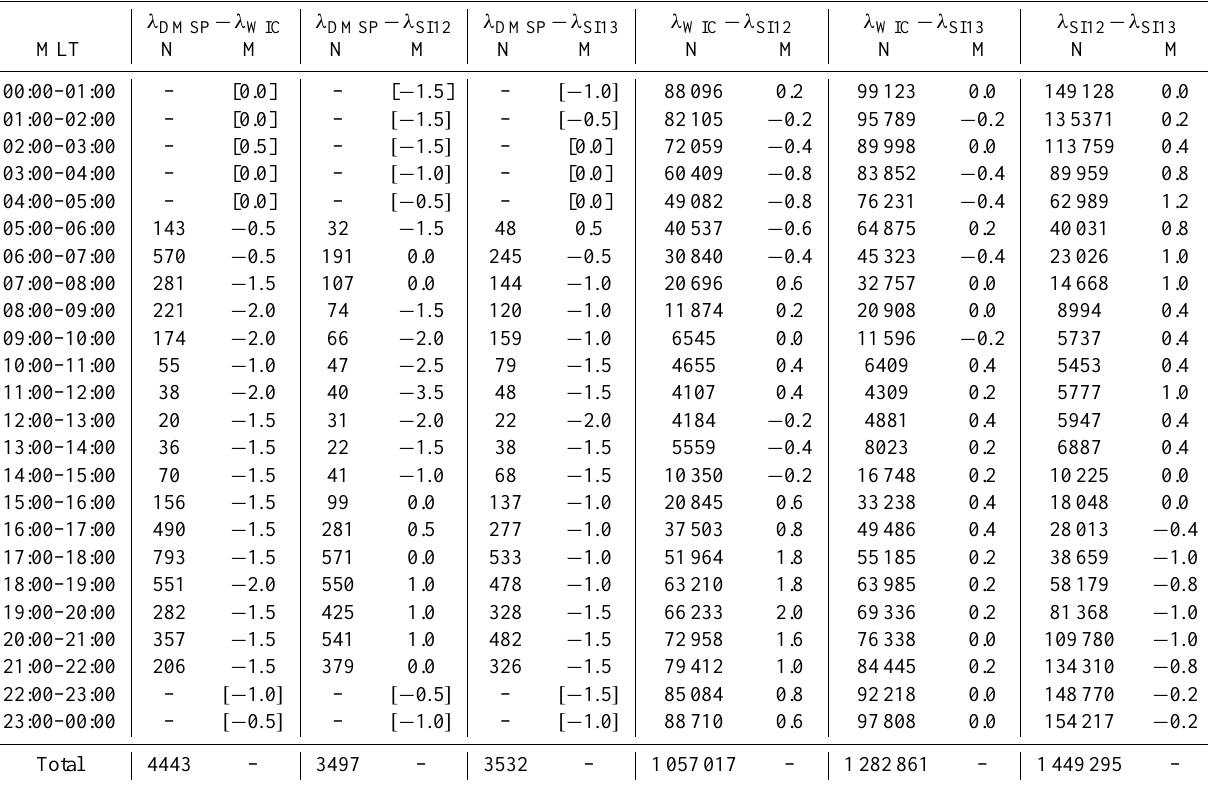
Table 3. The number (N) and mode (M) of comparisons of differences between DMSP PAPBs and FUV PALBs during 2000 and 2001 and inter-camera comparisons from May 2000 to August 2002. All available boundaries have been included. Estimated values for modal differences are shown in square